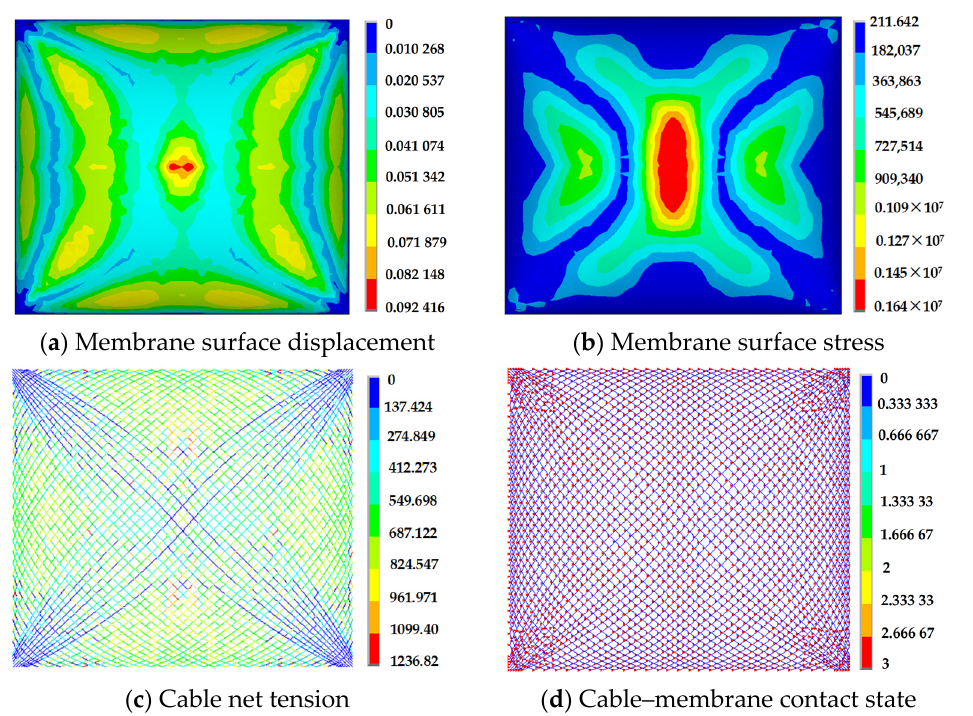
Figure 10. Cable–membrane internal force in bound contact state.